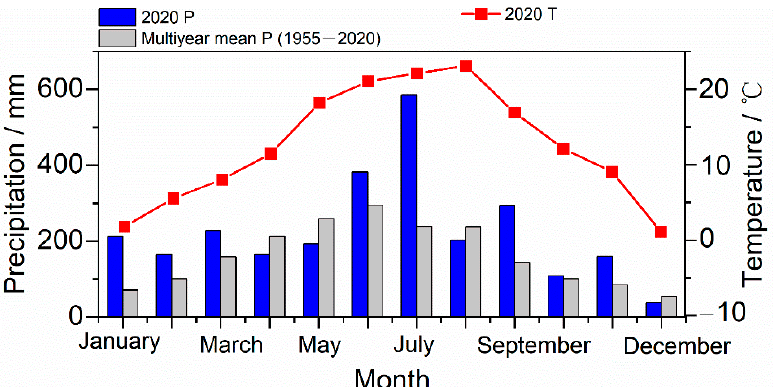
Figure 2. Monthly variation of multiyear precipitation (1955–2020), temperature, and precipitation in 2020 in the study site.